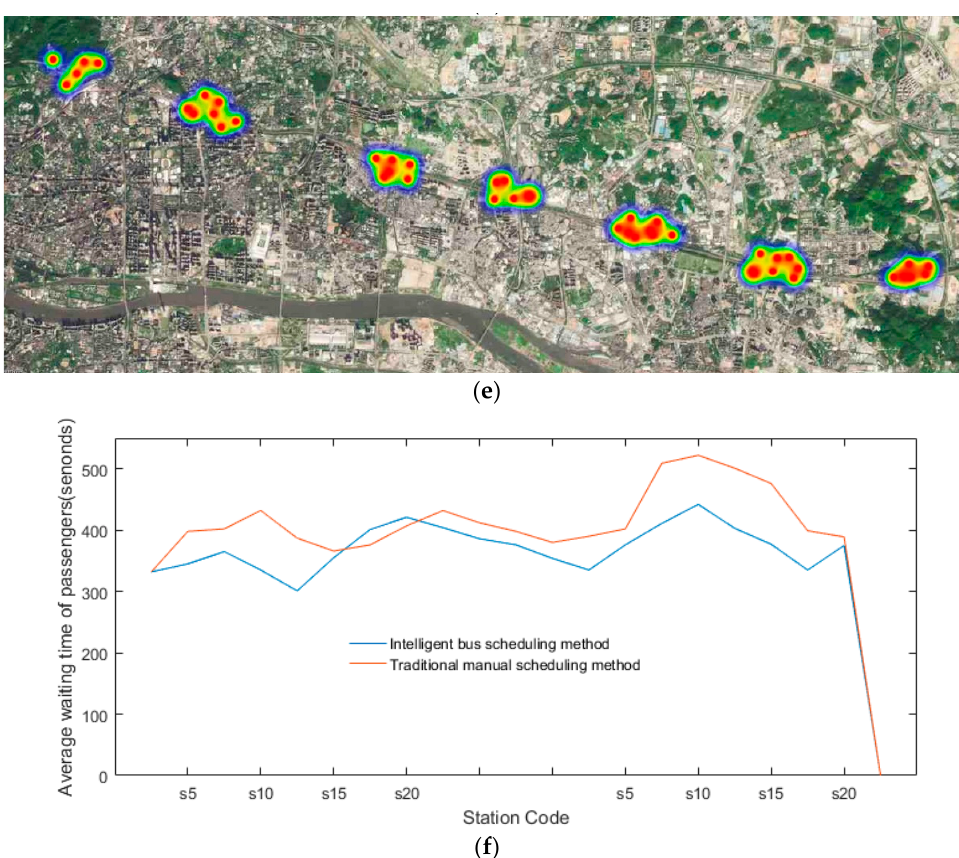
Figure 5. ( a ) Travel thermodynamic diagram at 8:45 obtained by the traditional bus scheduling method. ( b ) Travel thermodynamic diagram at 8:45 obtained by the proposed bus scheduling method. ( c ) Dispatching results comparison by average waiting time of passengers. ( d ) Travel thermodynamic diagram at 9:00 obtained by the traditional bus scheduling method. ( e ) Travel thermodynamic diagram at 9:00 obtained by the proposed bus scheduling method. ( f ) Dispatching results comparison by average waiting time of